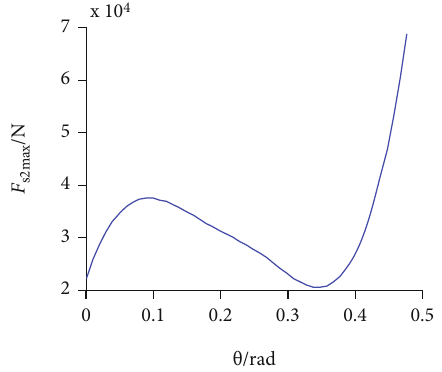
Figure 25: The maximum force of the secondary strut 2 varies with the lunar inclination.